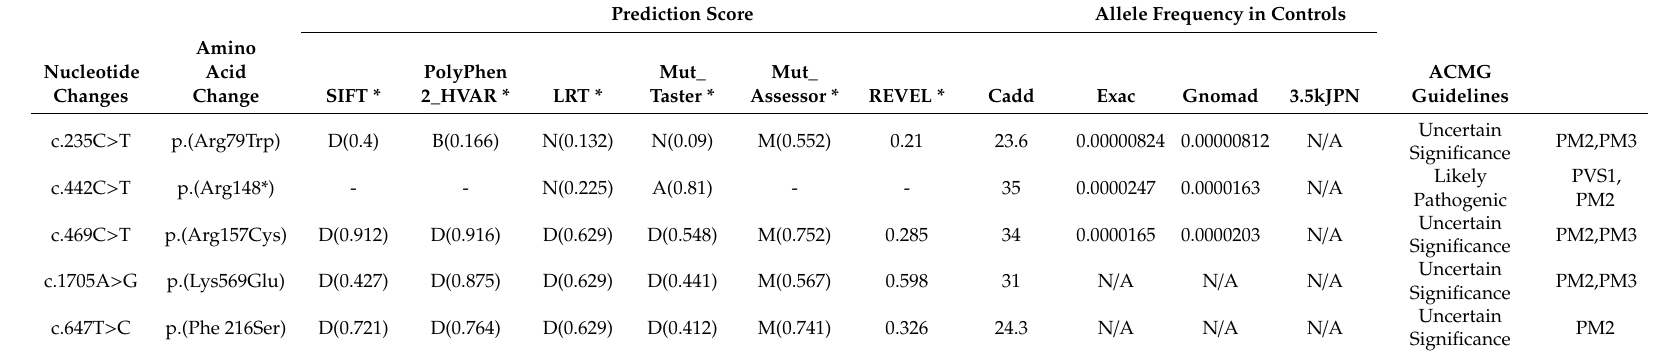
Table 2. Possible causative variant identified in this